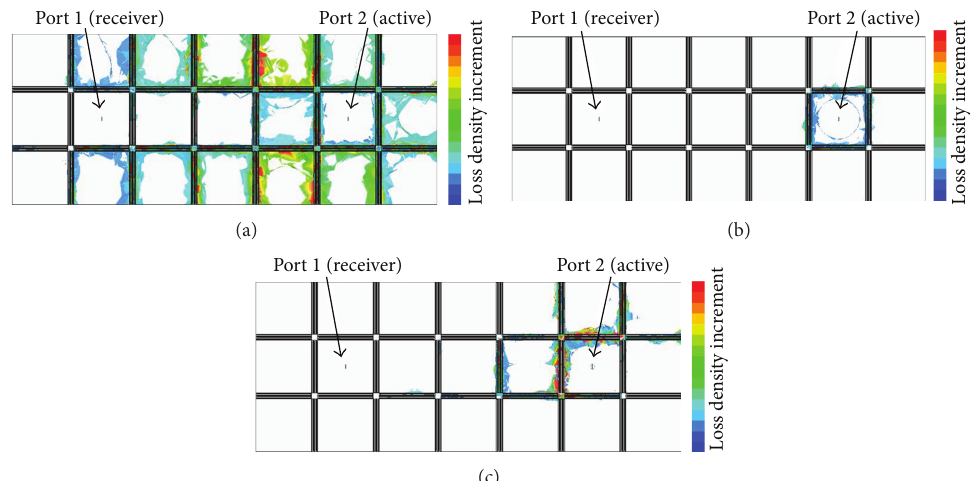
Figure 8: Material power loss density per volume inside the EBG-patterned parallel-plane setup: (a) at 2GHz, (b) at 3.5 GHz, and (c) at 4.5 GHz.